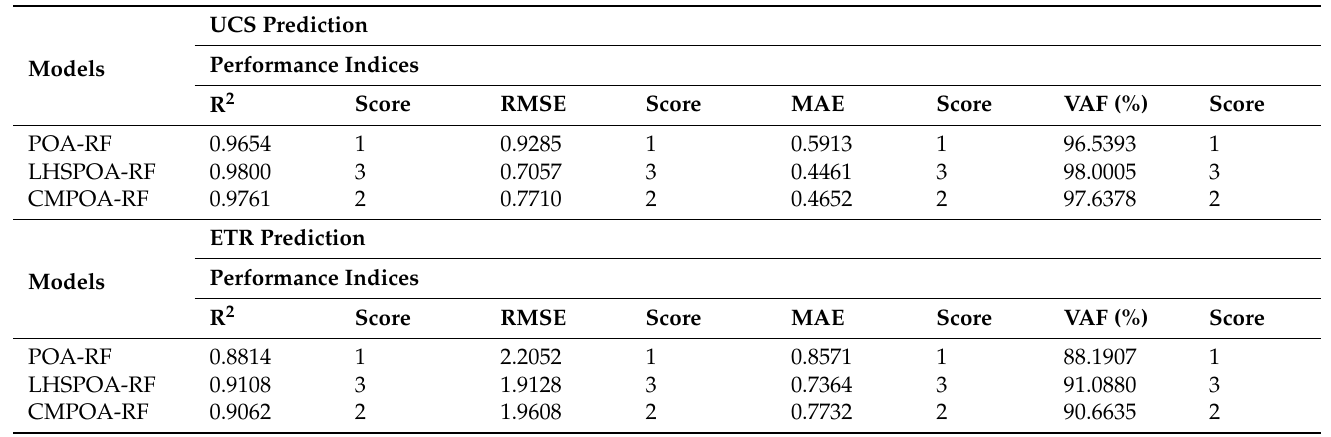
Table 6. The performance indices of the proposed models in the training